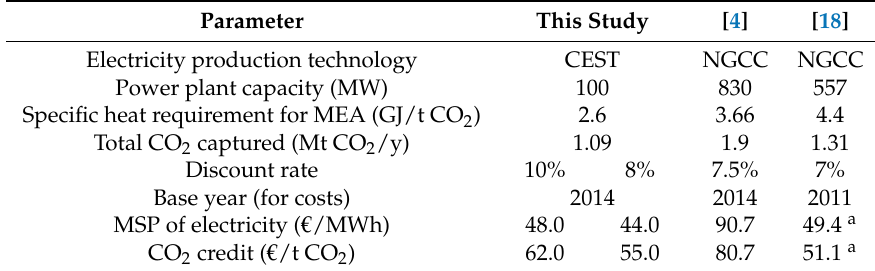
Table 5. Comparison among similar cases of CCS in thermal power